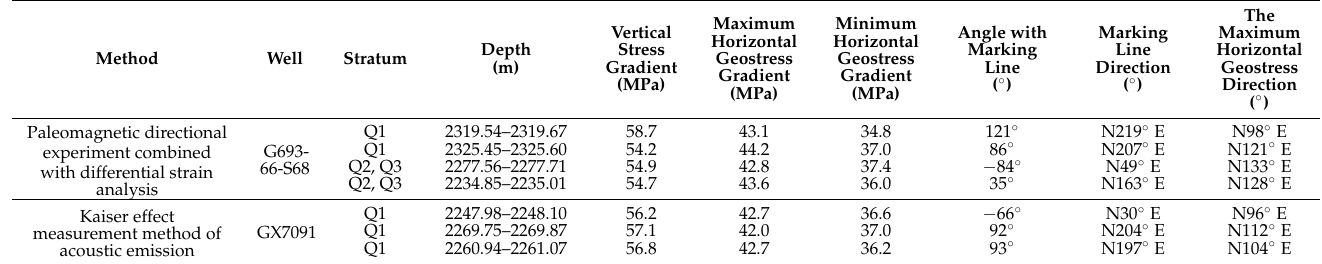
Table 1. Experimental results of earth stress in Block